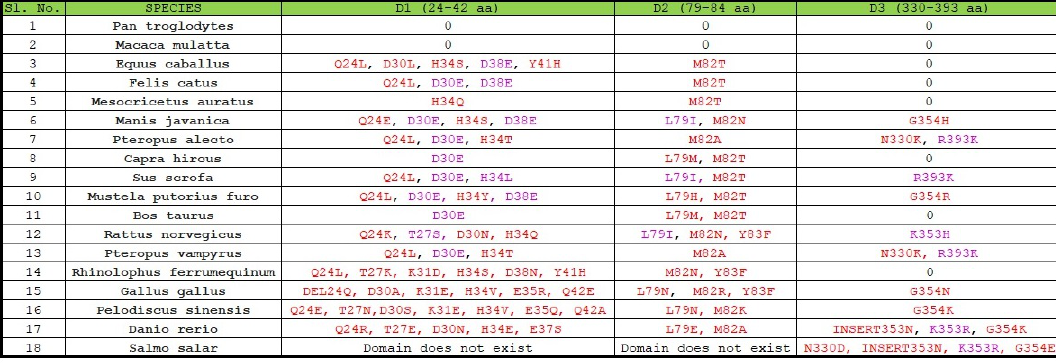
Figure 1. Substitutions in D1, D2, and D3 domains of ACE2 across eighteen